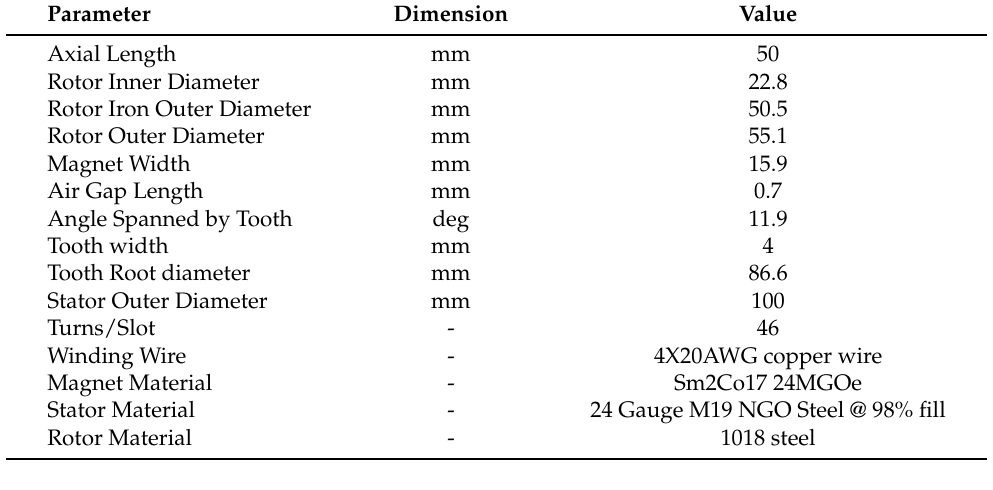
Table 1. The main geometric and material parameters of the BLDC machine model [52,53].